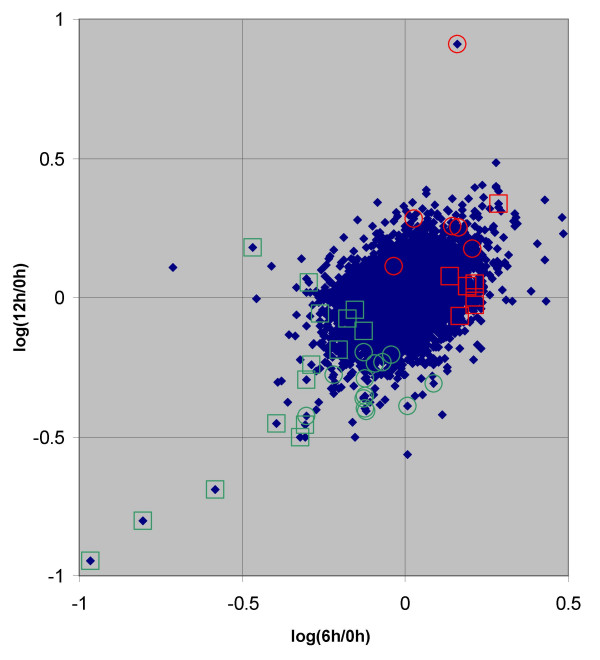
12 h/0 h versus 6 h/0 h signal ratios for MOE430A/B probe sets. Values are m6, the median of the three 6 h/0 h signal ratios, and m12, the median of the three 12 h/0 h signal ratios, in the three time series (section 2.2). Marked data points correspond to the 42 probe sets selected from the MOE430A data using SAM (section 2.4). Green squares: 15 probe sets down-regulated at 6 h; green circles: 13 probe sets down-regulated at 12 h; red circles: 7 probe sets up-regulated at 12 h; red squares: 7 probe sets up-regulated at 6 h. The data underlying this table are available [see Additional file 1].